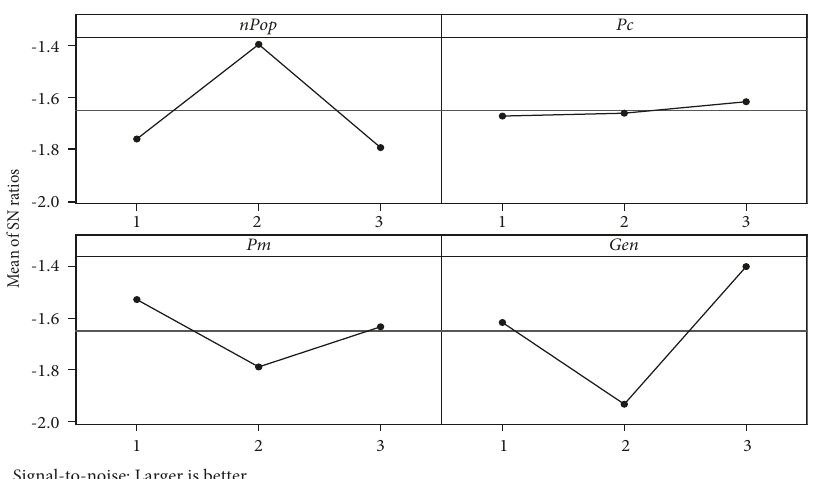
Figure 4: Values of different levels of parameters in S/N ratio for NSGA-II.